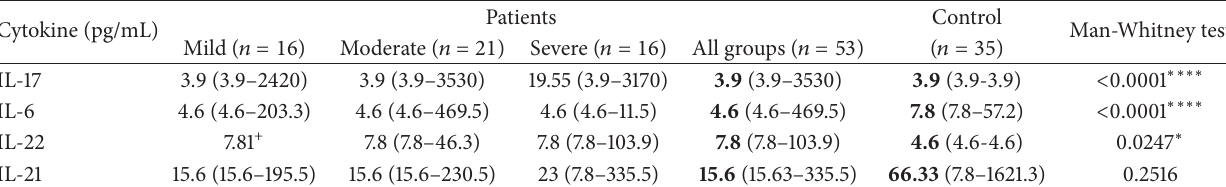
Table 2: Serum cytokines in psoriasis patients and healthy controls. Cytokine